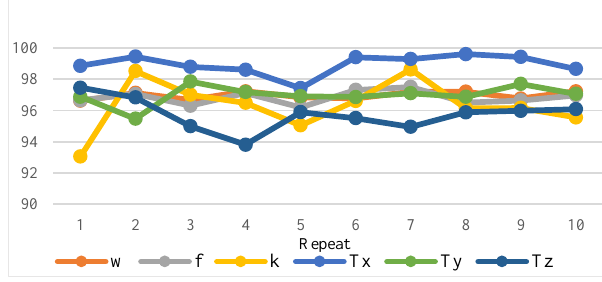
Figure 11. Relative accuracy for each registration parameter (percent).